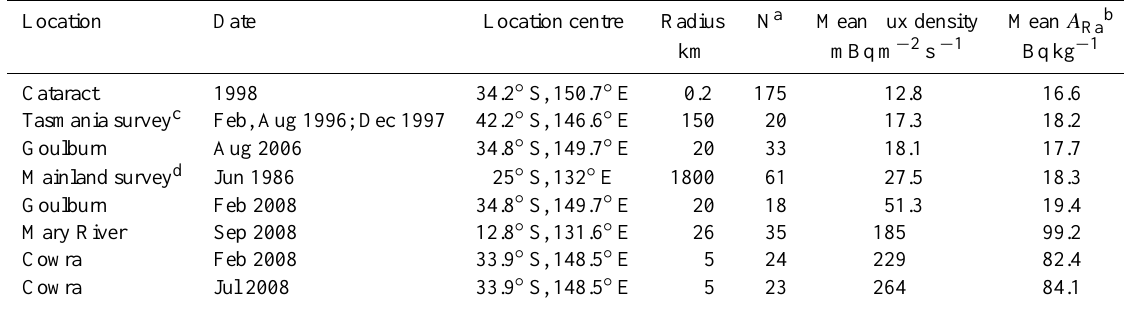
Table 1. Accumulation chamber measurements of radon flux density ordered by mean flux